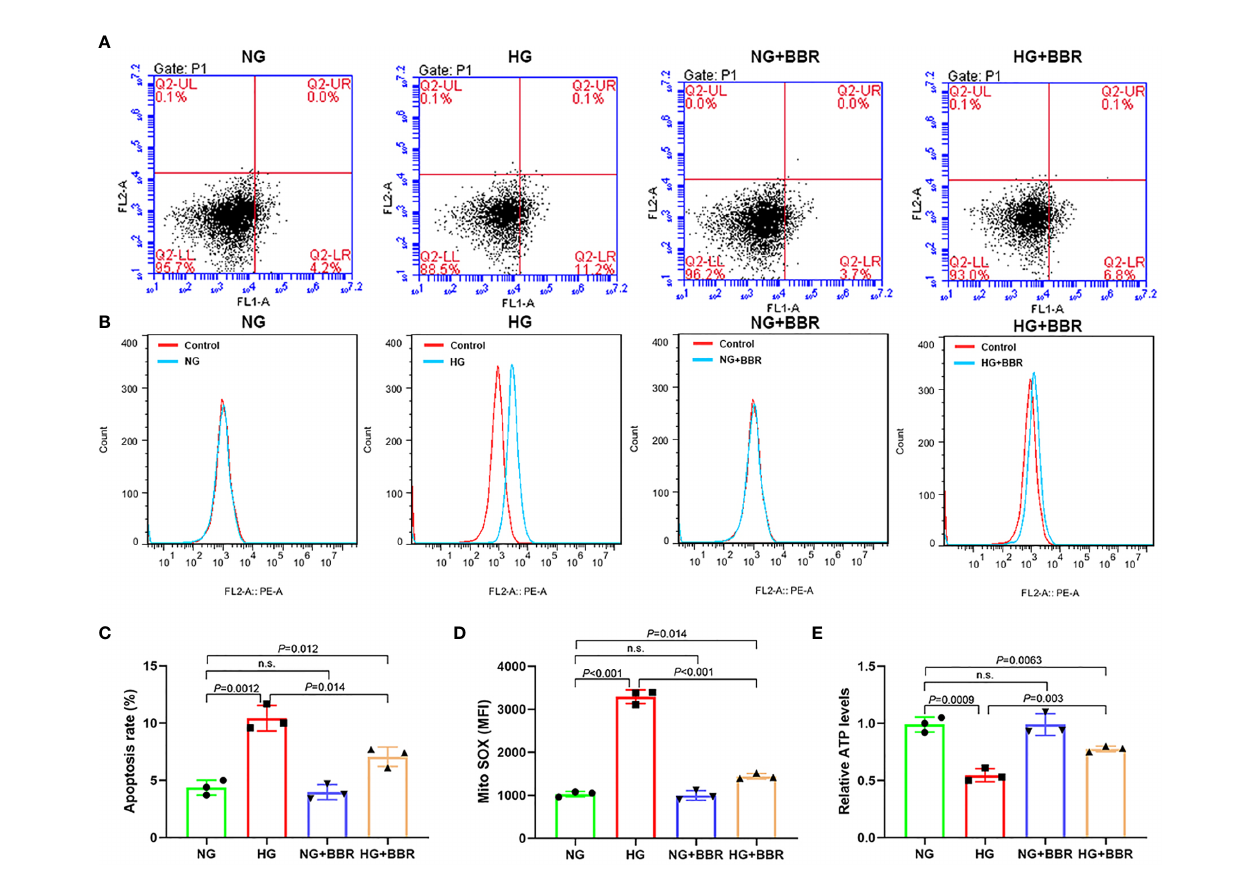
FIGURE 1 | BBR could regulate the mitochondrial bioenergetics of HK-2 cells under HG condition. (A, C) The effect of BBR on the apoptosis of HK-2 cells under HG condition detected by fl ow cytometry. (B, D) The effect of BBR on the mitochondrial ROS under HG condition detected by fl ow cytometry. (E) Relative ATP content in HK-2 cells of different groups. Cell culture experiments were repeated at least three times. n.s., no signi fi